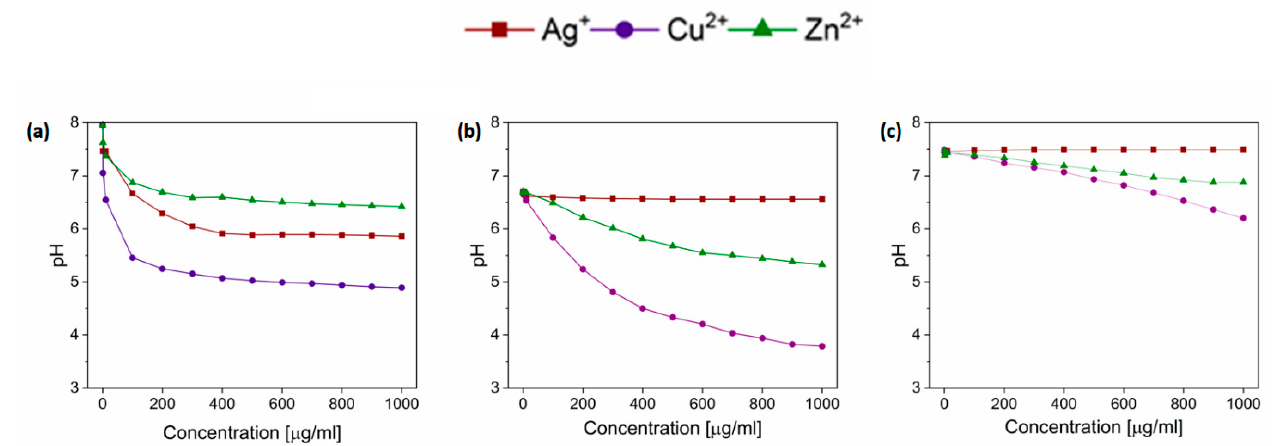
Figure 4. pH changes after addition of metal ions to chosen solutions: ( a ) distilled water, ( b ) non- diluted LB, ( c ) MOPS medium.